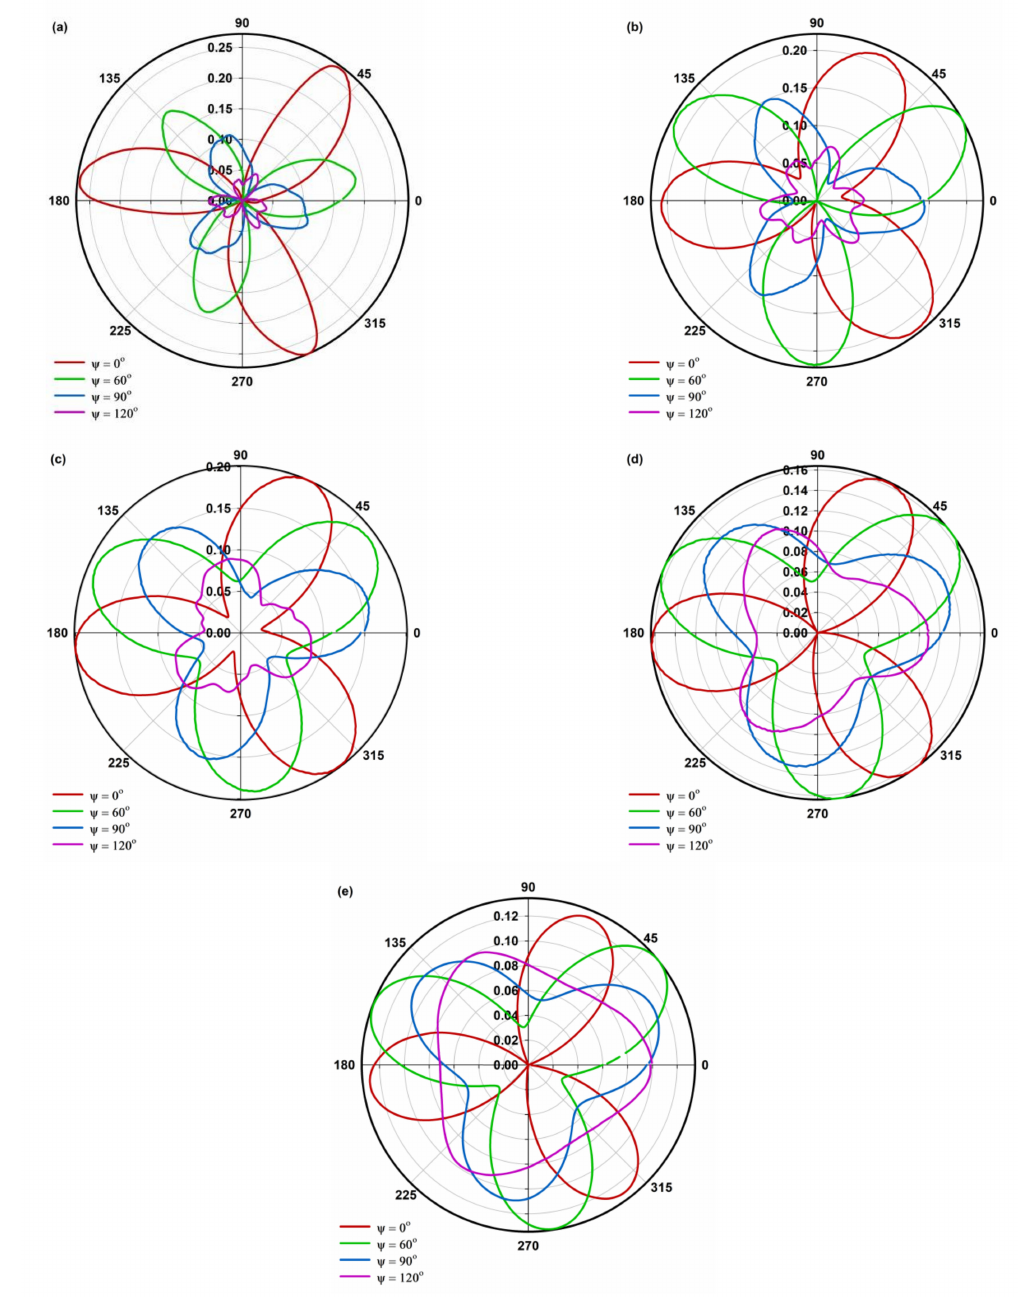
Figure 12. Cumulative polar plot of C m comparing different helix angles and a straight blade at ( a ) TSR = 2.3, ( b ) TSR = 2.5, ( c ) TSR = 3.1, ( d ) TSR = 3.5, ( e ) TSR =